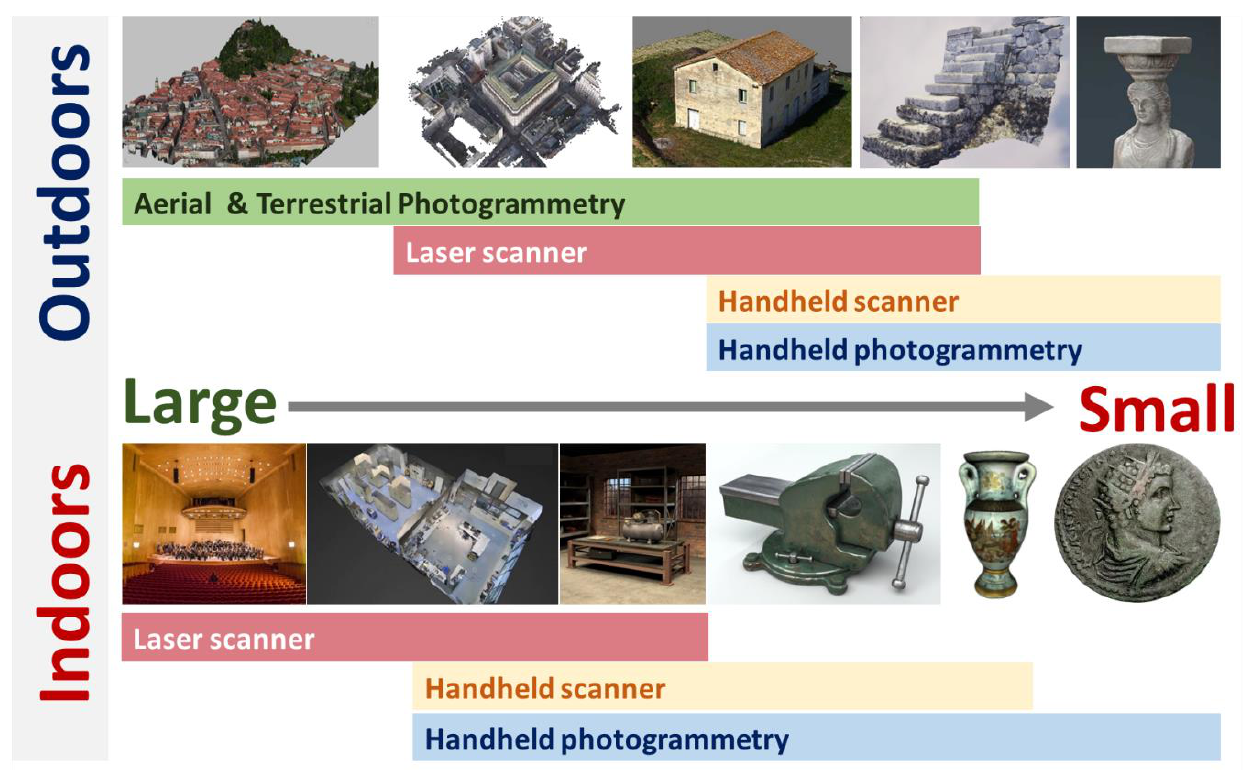
Figure 3. 3D scanning modalities and use cases in CH.